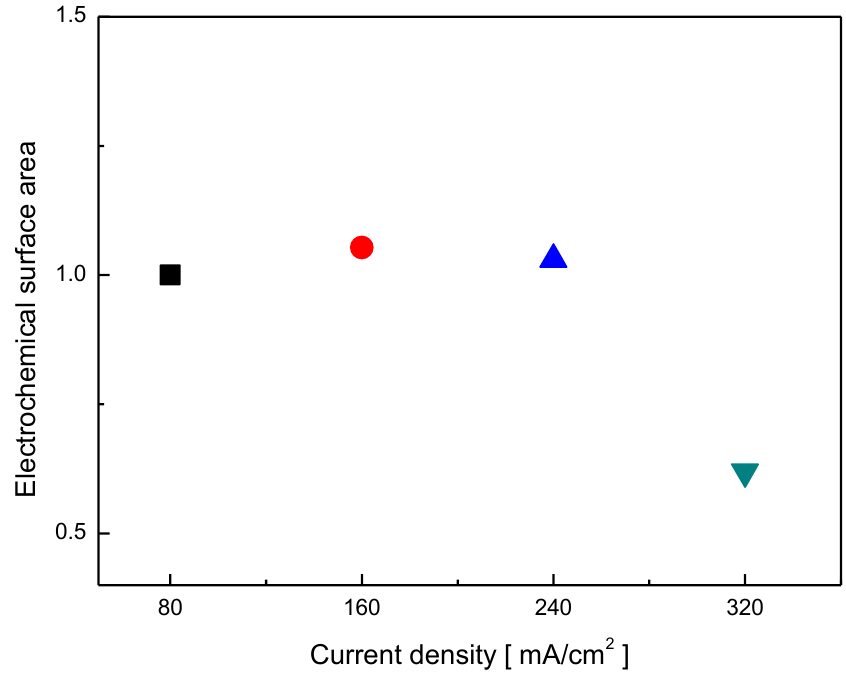
Figure 5. Electrochemical surface area of electrodeposited Ni–Zn–Fe on a Ni plate bath (E) with different current densities.